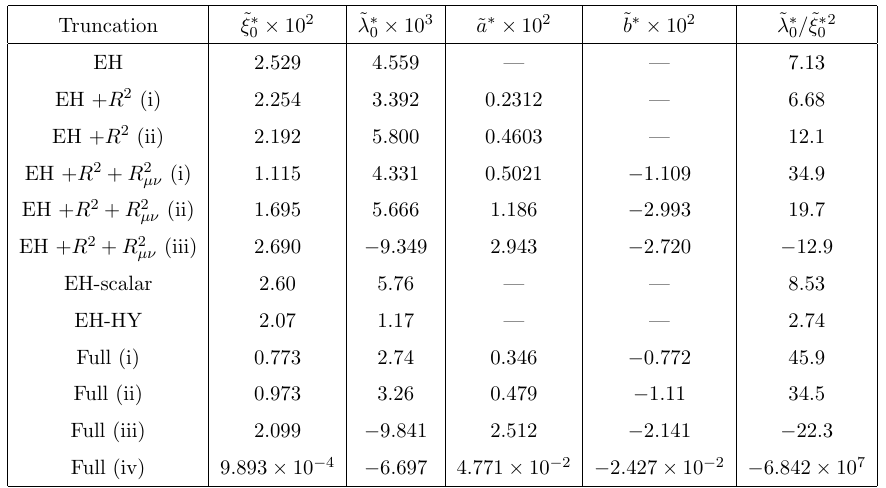
Table 1 . The values of (cid:12)xed points for (cid:11) = 0 and (cid:12) = 1. \EH", \HY" and \Full" denote the Einstein-Hilbert truncation, the Higgs-Yukawa term and the theory space (2.1),